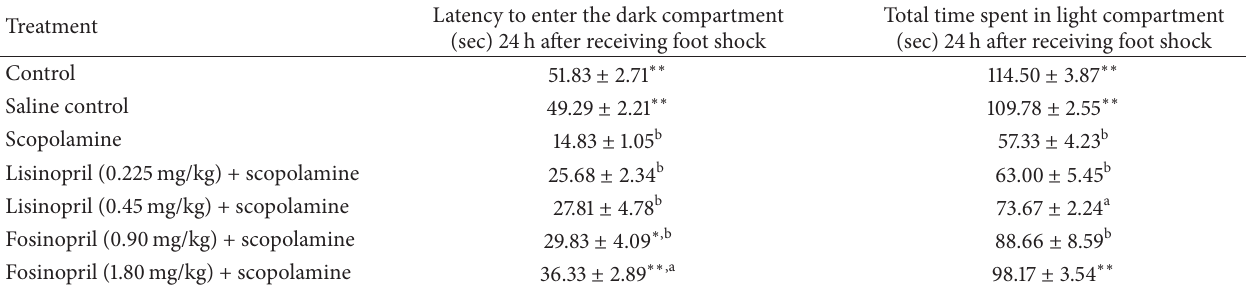
Table 3: Effects of lisinopril and fosinopril on memory retention behaviour of scopolamine-induced amnesic rats in passive avoidance test.